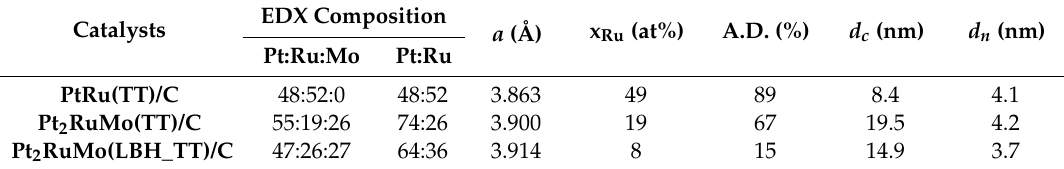
Table 1. EDX composition, XRD lattice parameter ( a ), Ru alloyed ( x Ru ), alloying degree (A.D.), XRD crystallite size ( d c ), and number average particle size ( d n ) of PtRu/C and Pt 2 RuMo/C catalysts.